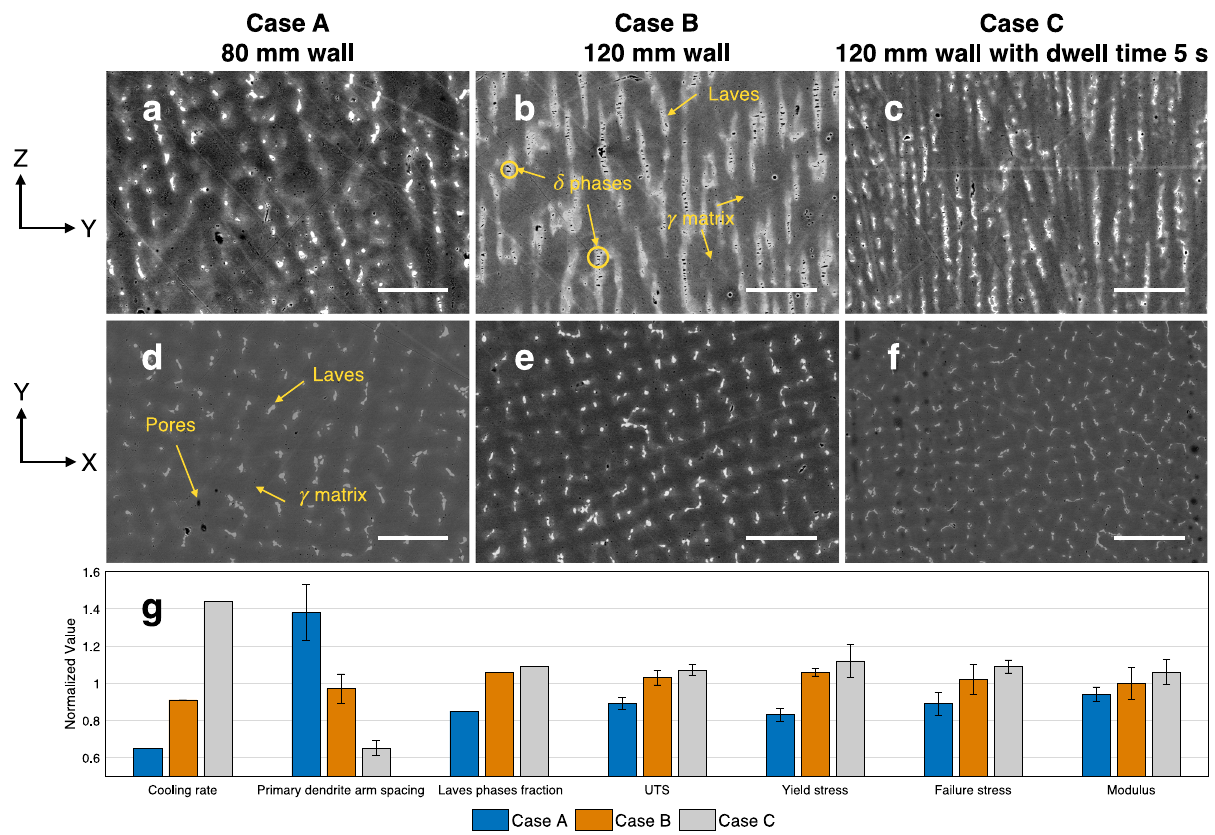
Fig. 3 SEM characterization of the microstructure for parts with different process parameters. High magni fi cation images a , b , and c are the side view (normal to the scan direction) of samples from the three cases, while d , e , and f show the top view (normal to the build direction). The locations of probed points are ( x , z ) = (8.3, 34.6) mm, (15, 32.8) mm and (15.1, 39.3) mm for Case A, B, and C respectively. Some original SEM images ( a – c ) are reprinted from ref. 74 with permission from Elsevier. g Comparison of computed cooling rate, microstructure, and mechanical properties of different thin walls. Values are tabulated in Supplementary Table 5 normalized by the mean across the three cases. The error bars for primary dendrite arm spacing, UTS, yield stress, failure stress, and modulus give standard deviations of repeated experiments. Cooling rate and volume fractions of Laves phases are calculated based on a single simulation and measurement and therefore have no standard deviation reported. The scale bars in ( a – f ) are 40 μ